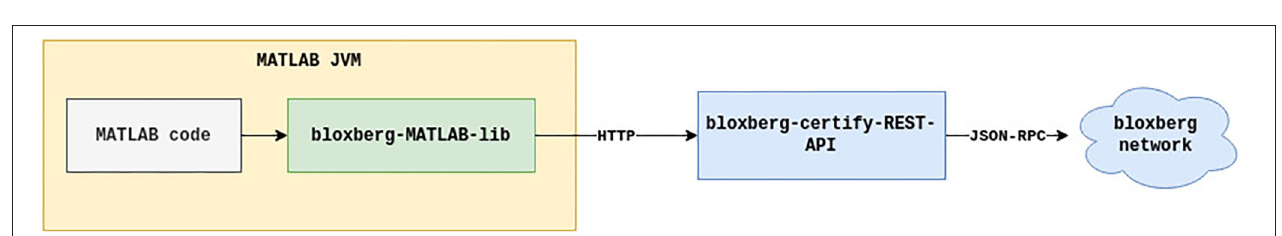
FIGURE 1 | Research data certification process in bloxberg Certify DApp.